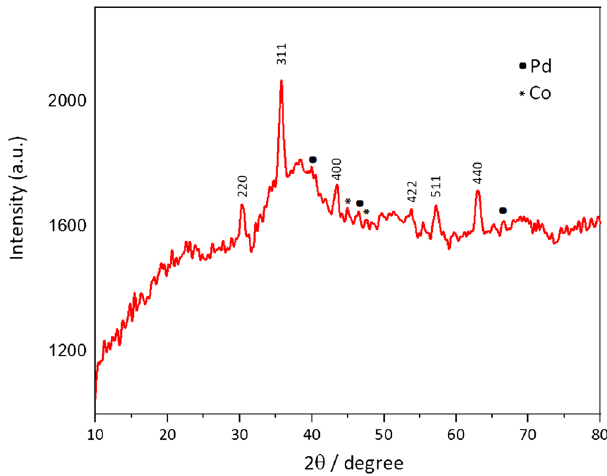
Figure 2. The XRD pattern of γ-Fe 2 O 3 @MBD/Pd-Co.